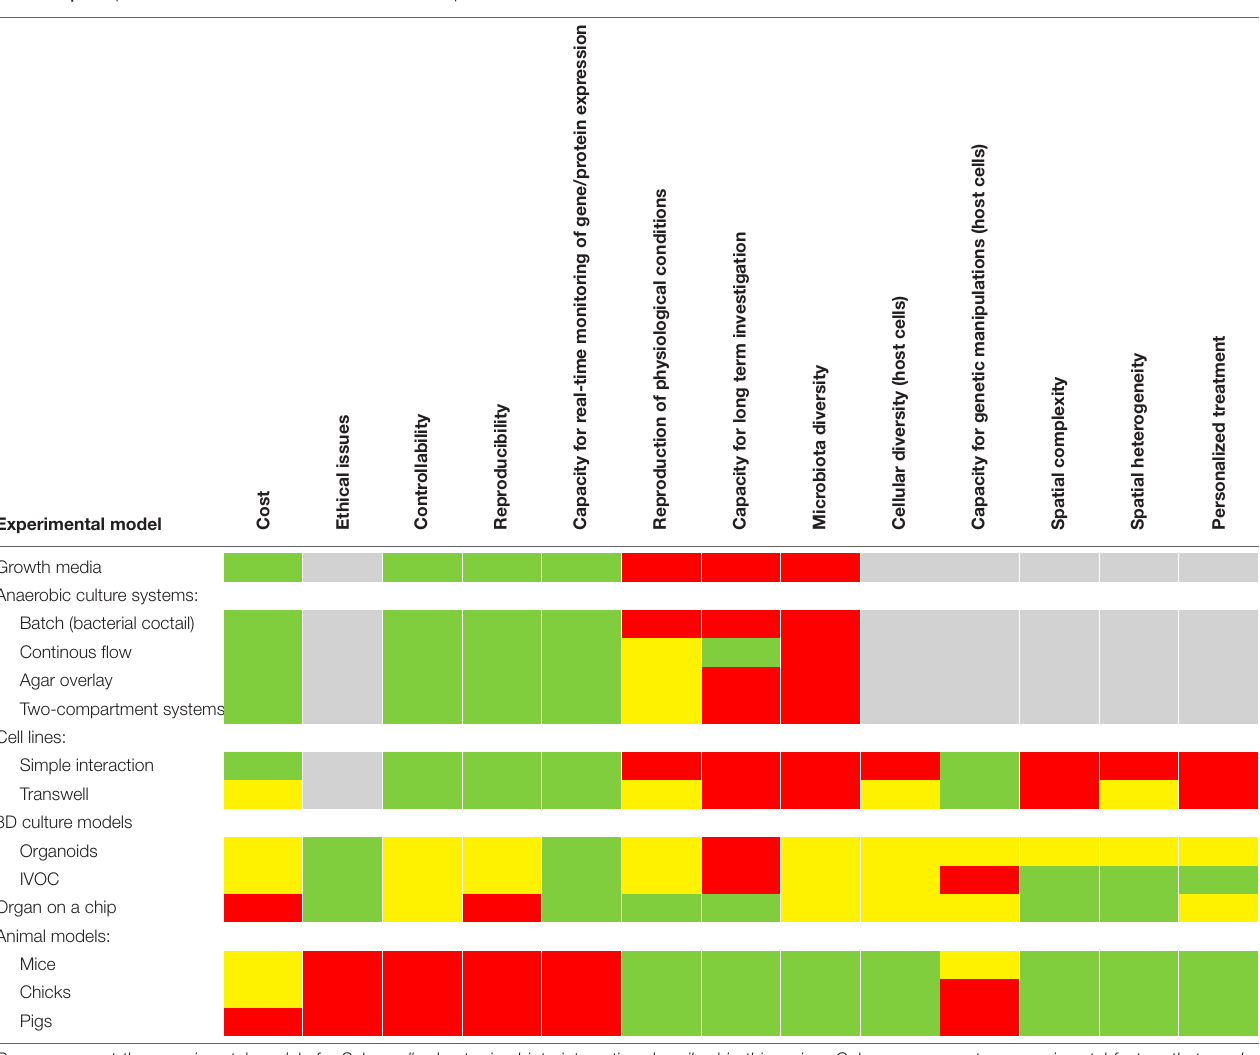
TABLE 2 | Comparison of various characteristics between experimental